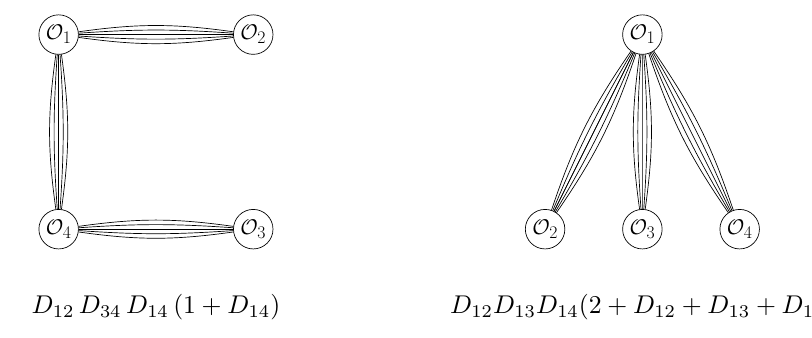
Figure 4 . Extremal topologies. At the bottom the corresponding generating function for the U( N ) c